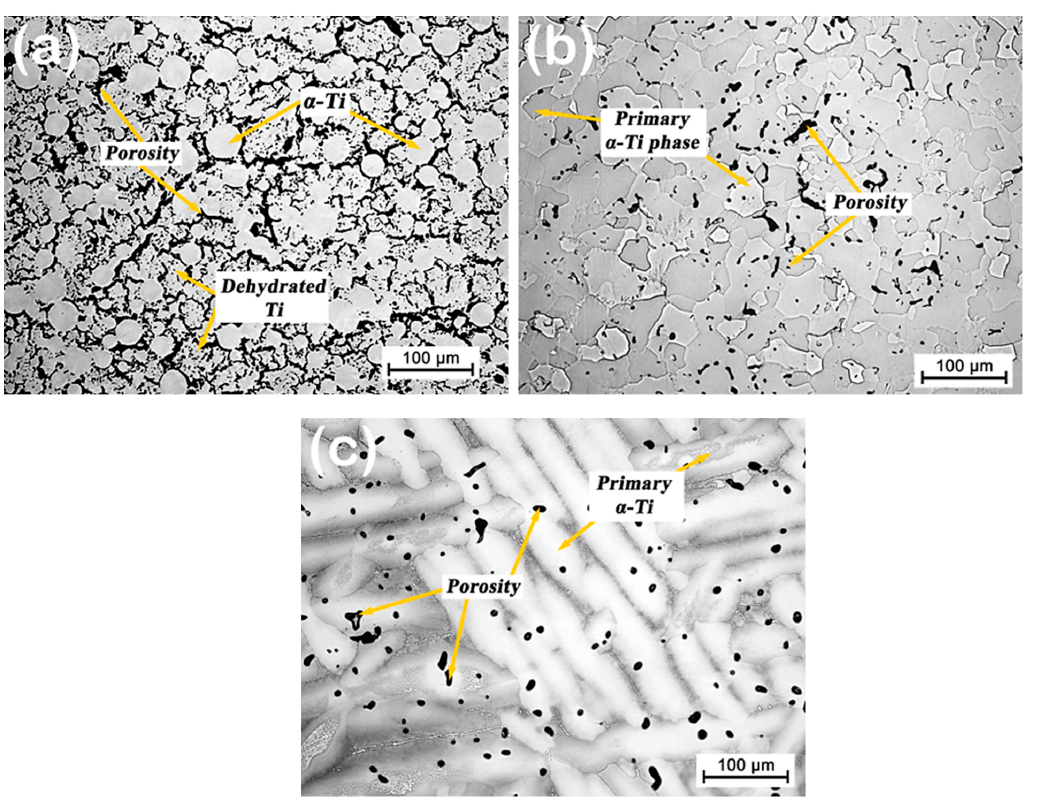
Figure 2. Optical micrographs for the microstructure of the unreinforced sintered samples at ( a ) U- a, ( b ) U-b and, ( c ) U-c. ( b ) U-b and, ( c )